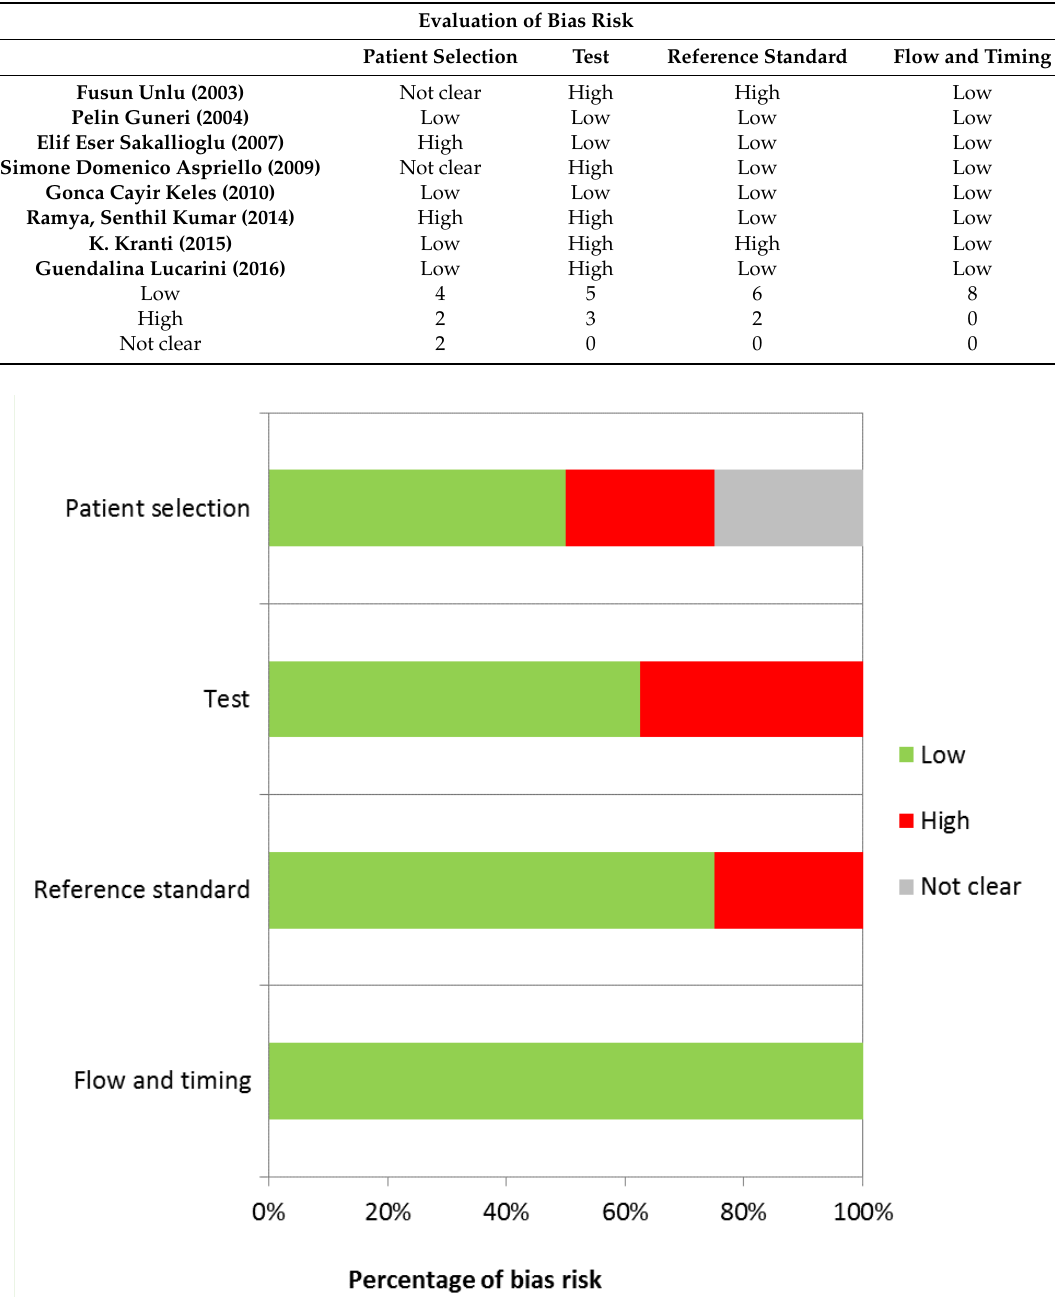
Table 3. Evaluation of bias risk.